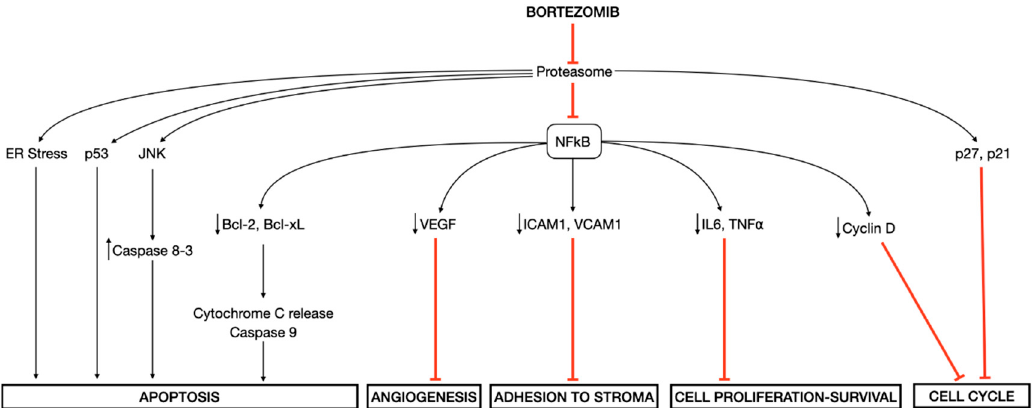
Figure 1. Molecular mechanisms of action of bortezomib. Bortezomib induces several downstream effects, among which the endoplasmic reticulum (ER) stress and the inhibition of transcription factor nuclear factor- κ B (NF- κ B) play a central role in mediating its cellular toxicity.